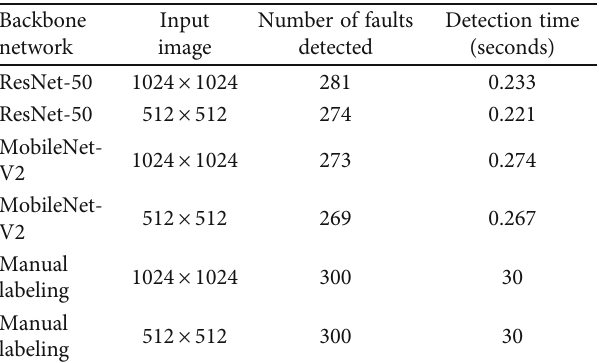
Table 3: Comparison of detection time of di ff erent backbone feature extraction